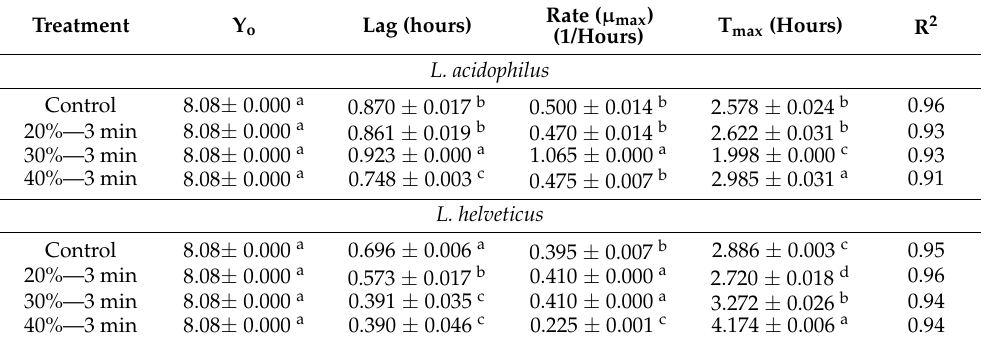
Figure 1. Effect of ultrasound (20 kHz) on the growth kinetics of L. acidophilus ( a ) and L. helveticus ( b ) at 37 ± 1 ◦ C. Table 1. Effect of ultrasound on the kinetic growth parameters of L. acidophilus and L. helveticus. (mean ± standard